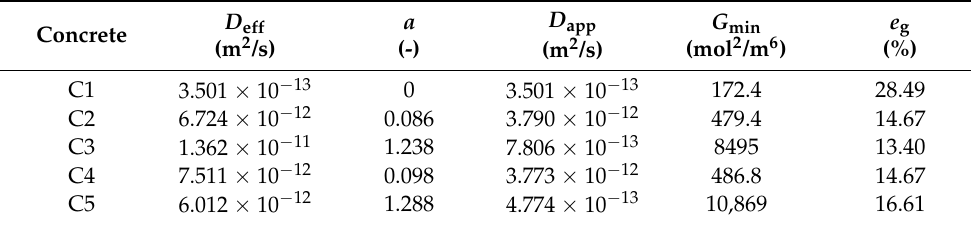
Table 5. The effective chloride diffusion coefficients ( D eff ), slopes of linear binding isotherm ( a ), and corresponding apparent chloride diffusion coefficients ( D app ) for concretes C1–C5. The results are obtained on the basis of minimalization of objective function G defined by Equation (29). The values of its estimated minimum ( G min ) and corresponding global errors ( e g ) of fitting the experimental to theoretical data are also given in the